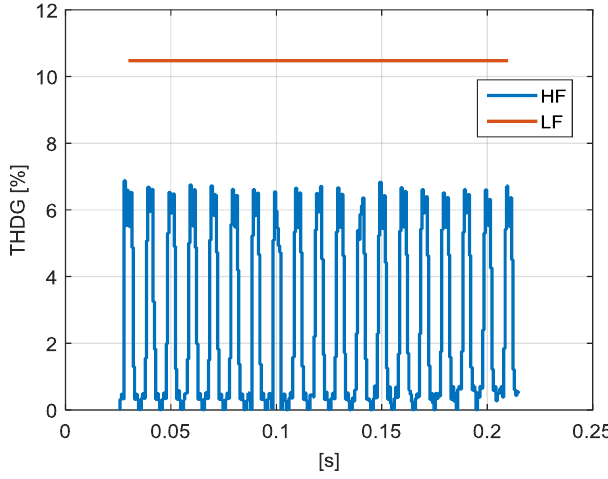
Figure 43. Case study 1: THDG at low-frequency (0 ÷ 2 kHz, red line) and at high-frequency (2 ÷ 150 kHz, blue line).